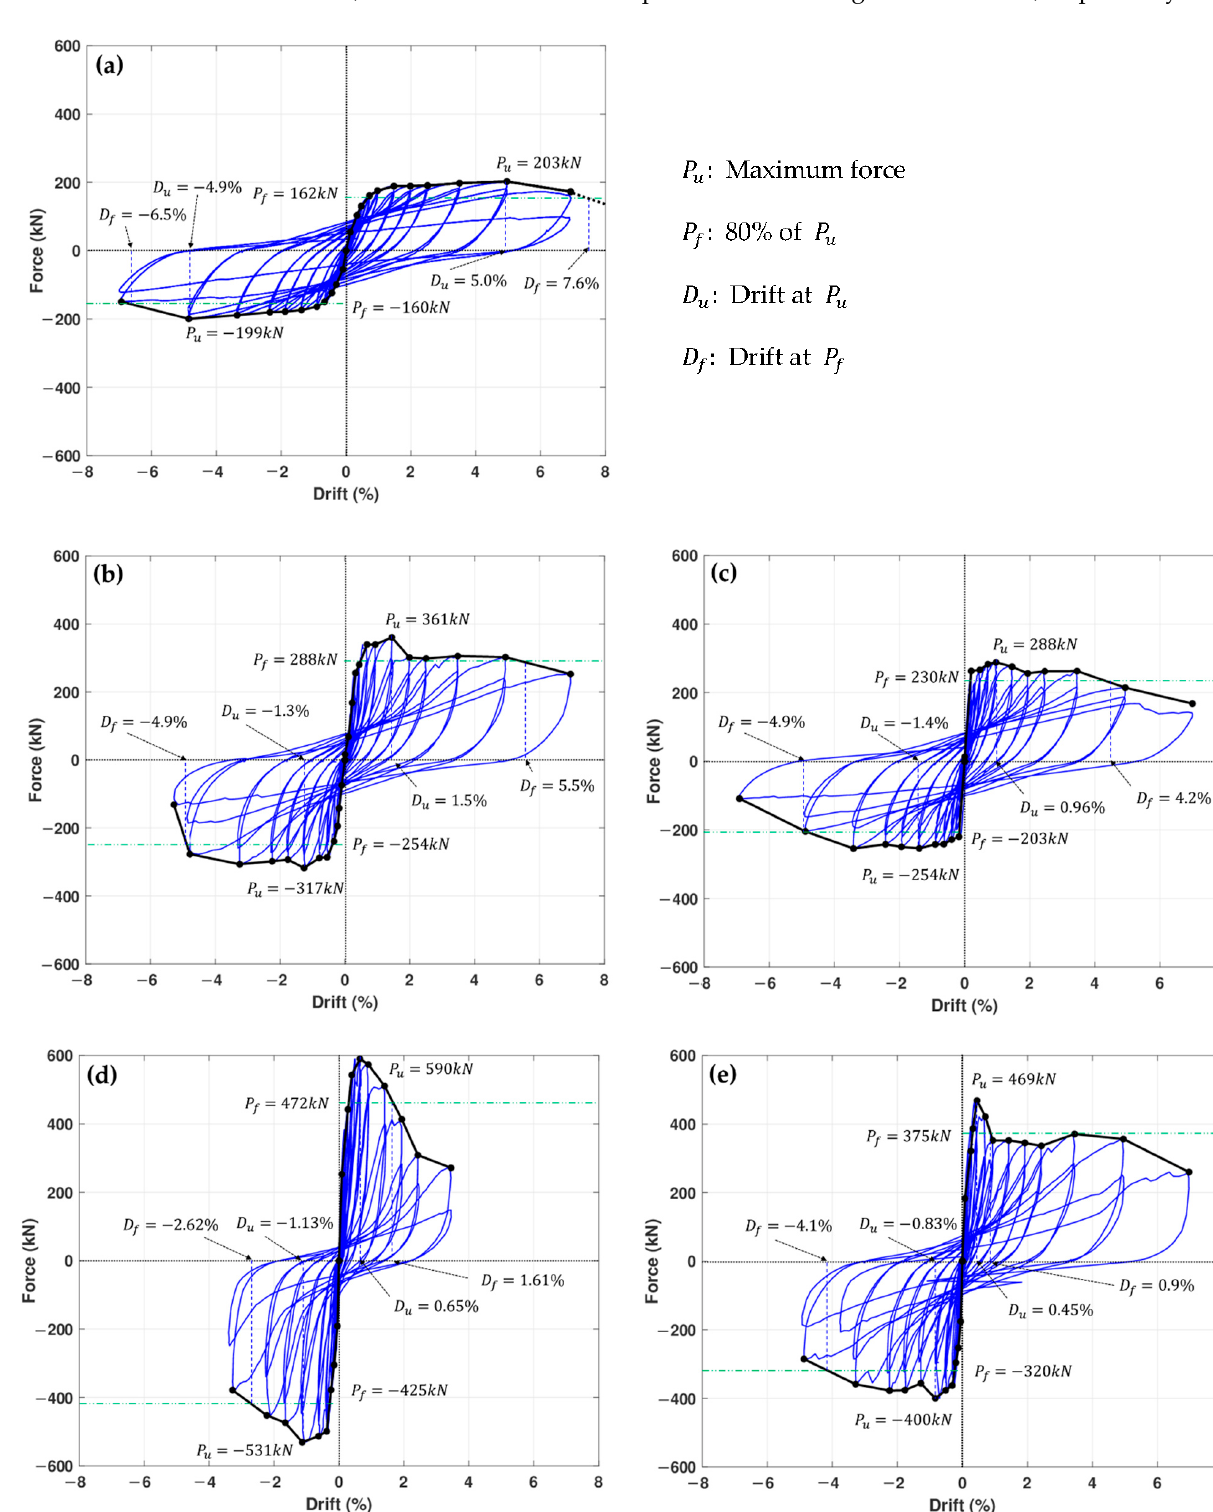
Figure 9. Force vs. drift curves. ( a ) BF. ( b ) IF-0.5. ( c ) IFS-0.5. ( d ) IF-1.0. ( e ) IFS-1.0. Compared to BF, the maximum forces of masonry-infilled frames were increased, but the deformation capacity was decreased. As expected, the maximum force was highest in IF-1.0 and lowest in IFS-0.5. Table 3 shows the maximum force and maximum displace- ment of each specimen and the strength ratio between the specimens with and without a gap. Specimens with gaps had a strength of 75% to 80% of specimens without gaps. In addition, the difference between the maximum force in the positive and negative direc- tions was large compared with BF. This is likely due to residual strain in the masonry infills accumulated from low drift ratios. The specimens with double wythe masonry walls had lower deformation capacity than those of single wythe specimens. In other words, the higher the strength ratio of ma- sonry compared to the frame, the lower the deformation capacity. This is consistent with the suggestion of ASCE 41 [25] for lower deformation capacity for the nonlinear modeling parameter of compression strut at a low value of 𝛽 , the strength ratio between the frame and the masonry infill ( 𝑉 (cid:3033)(cid:3045)(cid:3032) / 𝑉 (cid:3036)(cid:3041)(cid:3032) ). The specimen with a gap exhibited a lower deformation capacity than the specimen without a gap. This is thought to be due to the fact that the masonry in a specimen with a gap was not constrained, and thus fracture strain would be low. Table 3. Maximum force and corresponding drift. Specimen ID